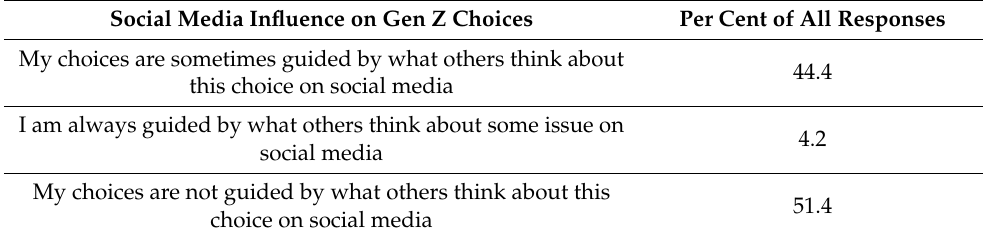
Table 3. Social media influence on Gen Z